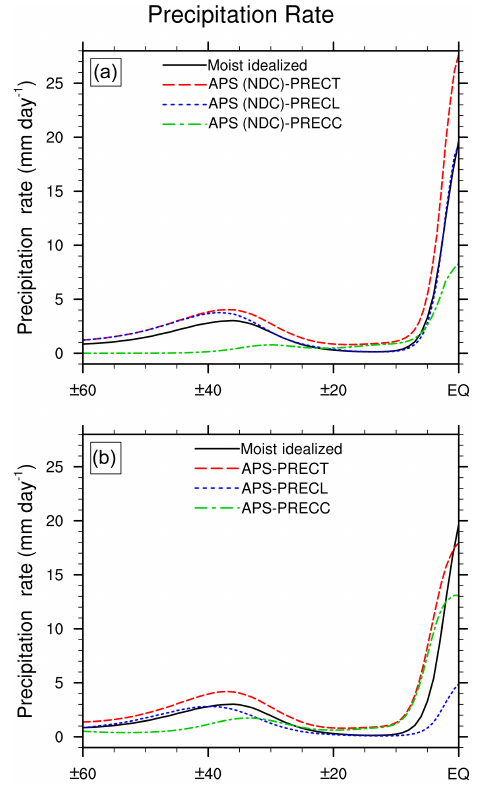
Figure 4. CAM5-SE time-mean zonal-mean precipitation rate (hemispherically averaged) for MITC (black) compared to (a) APS (NDC) and (b) APS. The total aquaplanet precipitation rate (PRECT, red dashed) is divided into the large-scale precipita- tion rate (PRECL, blue dotted) and convective precipitation rate (PRECC, green